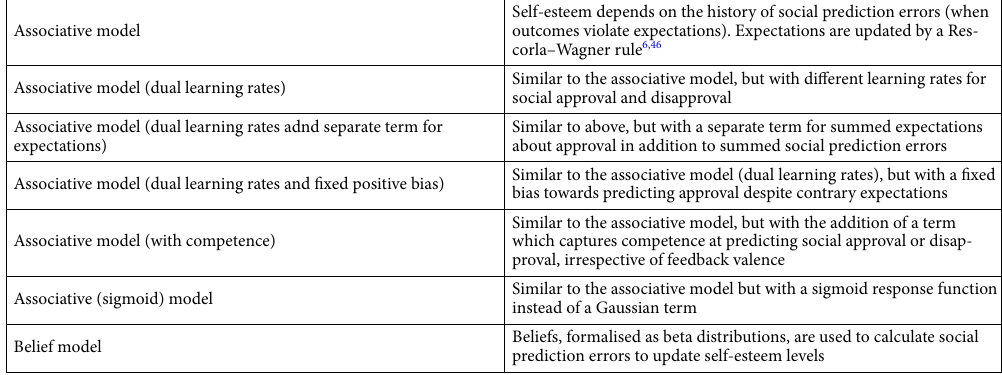
Table 5. An overview of the model space being